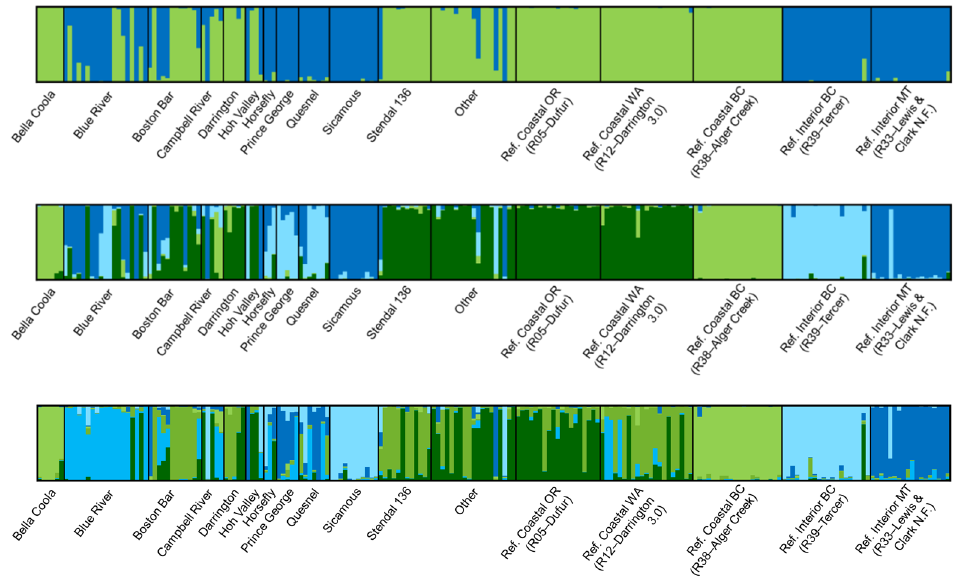
Figure 2. Membership proportion of individuals (slim bars) to clusters identified by the STRUCTURE (Bayesian clustering) analysis (green = coastal, blue = interior) for K = 2, 4 and 6 modelled clusters. Individuals belonging to the same reference population (as listed in Table 1) are marked by black boarder lines. The first 12 boxes from left to right (Bella Coola to Other) include the 108 Swedish clones, while the last five boxes include the five native reference populations. BC = British Columbia, Canada; MT = Montana, USA; OR = Oregon, USA; WA = Washington, USA. At K = 4, splits could be observed within both varieties, separating northern from southern origins. Within the coastal variety, the southern reference populations Dufur (Oregon, OR, USA) and Darrington 3.0 (Washington, WA, USA) belonged to a different cluster than the northern Alger Creek (British Columbia, Canada) (Figure 2). Henceforth, we refer to these two clusters as the southern and northern coastal cluster,